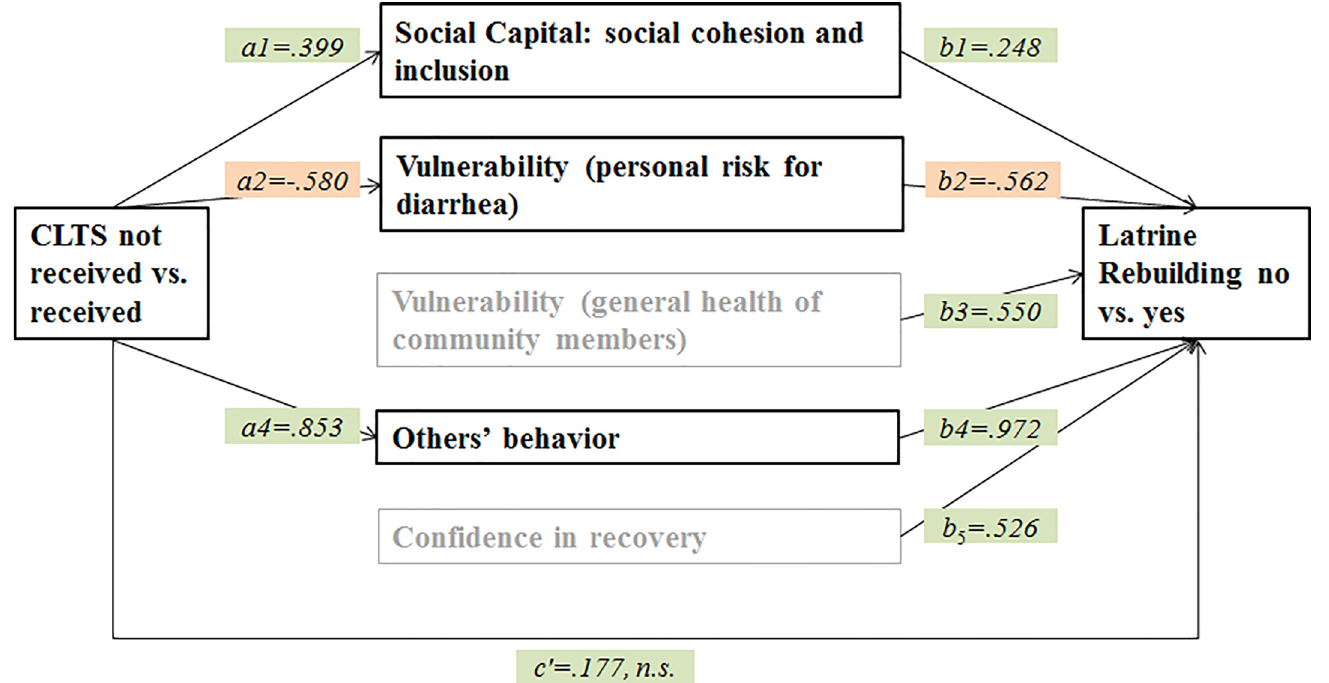
Fig 5. Statistical diagram of the multiple mediation model for the indirect influence of CLTS on latrine rebuilding through several social and psycho-social context factors. CLTS received was coded ‘1’ and CLTS not received was coded ‘0’. Latrine rebuilding was coded ‘1’ and no latrine rebuilding was coded ‘0’. a1 – a4 = unstandardized regression coefficients from linear regressions; b1 –b5 = unstandardized regression coefficients from logistic regression; c’ = indirect effect of CLTS on latrine ownership